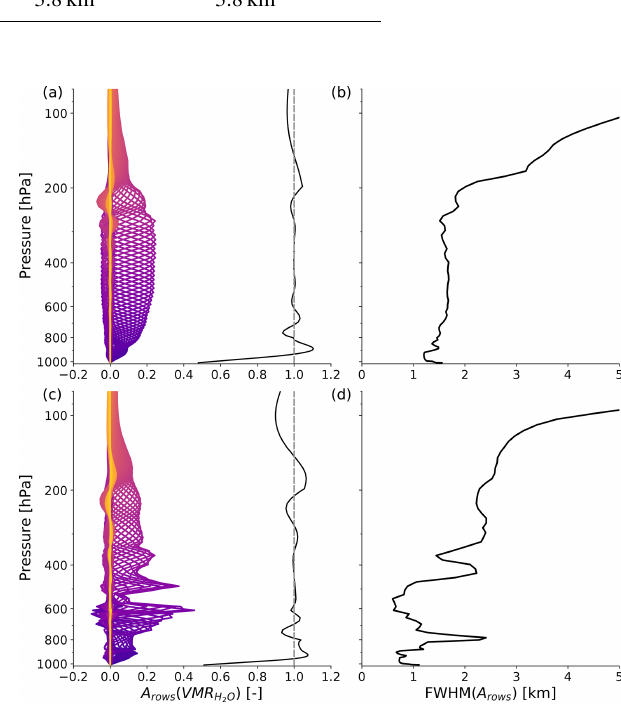
Figure 5. Panels (a) and (c) show rows of the water vapour aver- ) ) as coloured lines and their aging kernel matrix ( A rows ( VMR H 2 O sum as a black line, which denotes the measurement response. The rather blue lines correspond to kernels closer to the surface, and the more yellow lines correspond to kernels at higher altitudes. Panels (b) and (d) show the FWHM of the averaging kernel rows, which is a measure for the vertical resolution of the observing system. Panels (a) and (b) are based on a mean tropical ocean atmosphere, specifi- cally the tropical FASCOD atmosphere. The atmospheric setup used for (c) and (d) differs only by the introduction of EML features, as described in Sect.